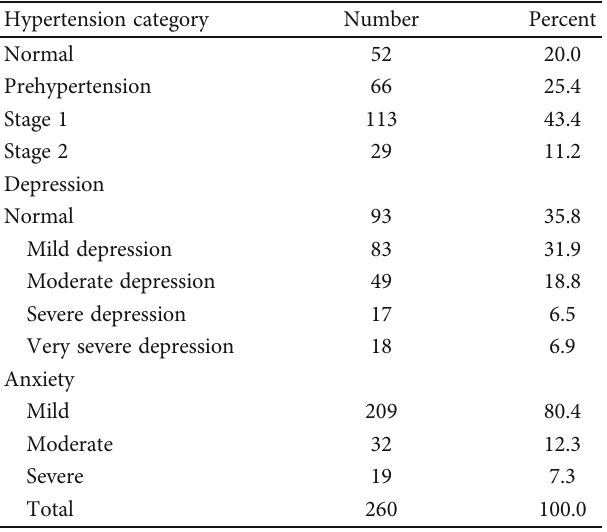
Figure 2: Comorbidities among the study participants ( n = 260 ). Table 2: Depression and anxiety according to Hamilton Depression Rating Scale and Hamilton Anxiety Rating Scale, respectively ( n = 260